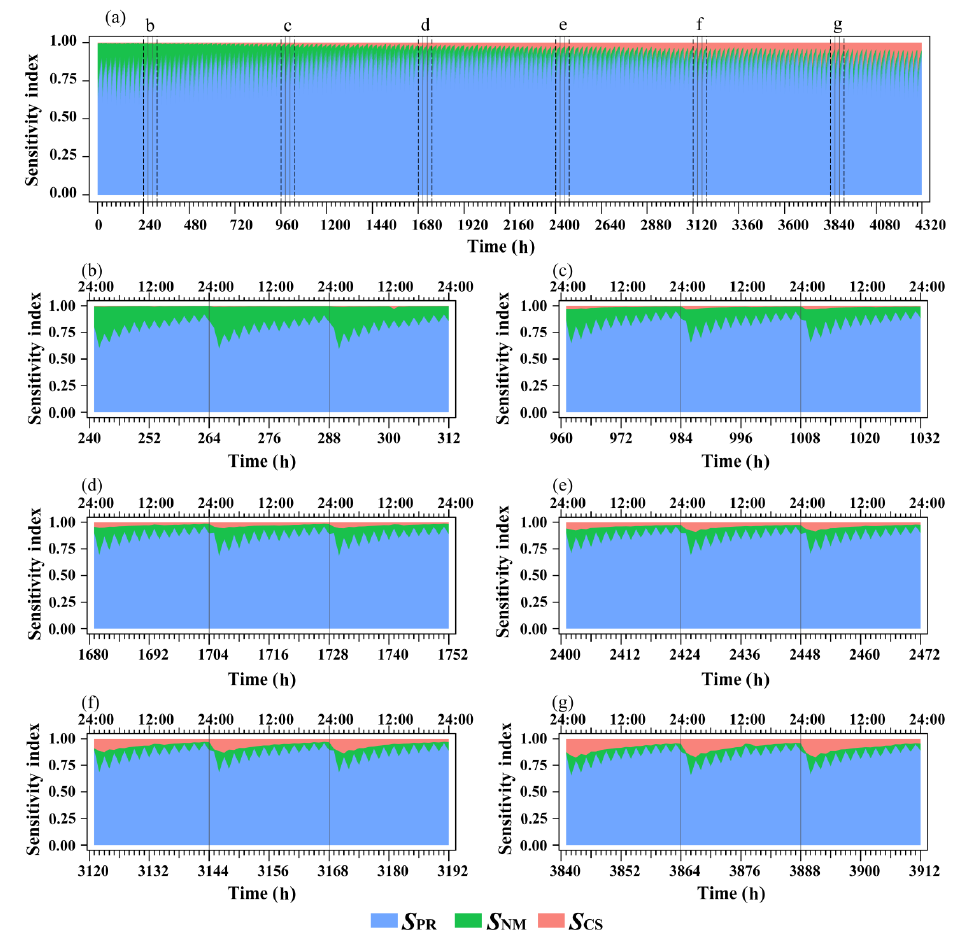
Figure 8. Estimated sensitivities for the spatially averaged groundwater contribution to stream flow ( Q G ) at whole time steps (a) . We chose six periods at 3d intervals to display the sensitivity index values in detail. The bottom six figures exhibit the sensitivity index results for 241–312h (b) , 961–1032h (c) , 1681–1752h (d) , 2401–2472h (e) , 3121–3192h (f) , and 3841–3912h (g) . S PR is the sensitivity index for parameters. S NM is the sensitivity index for models and represents the influence of aquifer thickness. The S CS is the sensitivity index for climate scenarios. The bottom x axis of (b–g) represents the simulated time steps, and the upper x axis of (b–g) represents the local time.